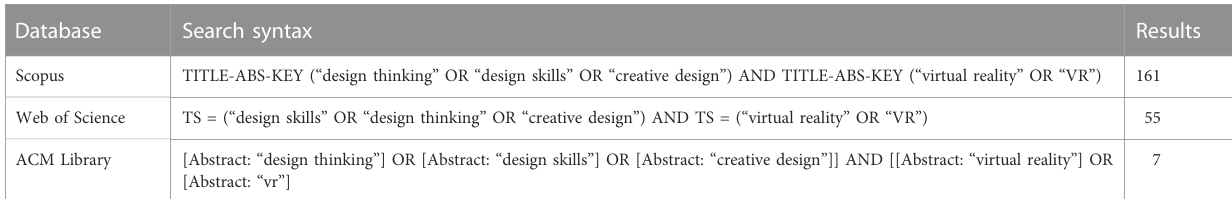
TABLE 1 Database and search syntax with the number of results (as on 30 April 2022).